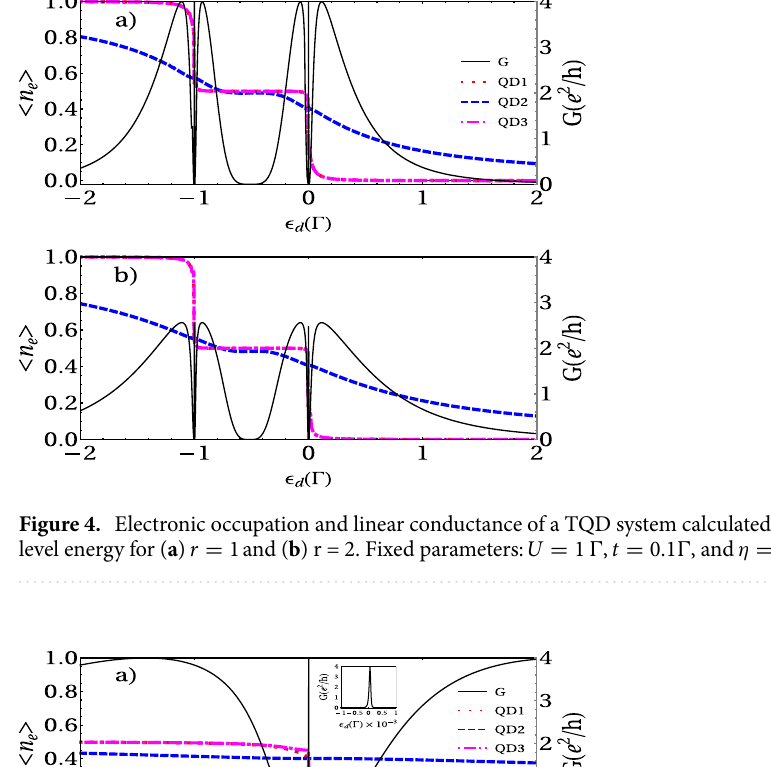
1 and ( b ) r = 2. Fixed parameters: U =